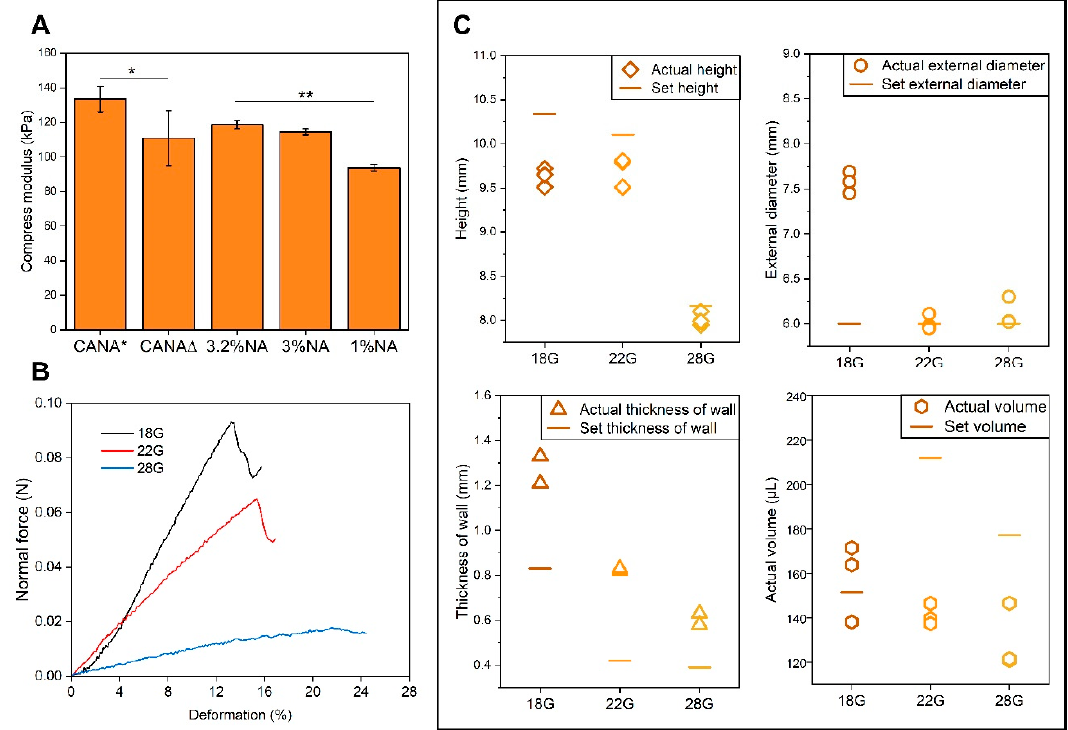
Figure 3. ( A ) Compressive modulus of di ff erent hydrogels at 4 ◦ C and 37 ◦ C (n = 3). (CANA * represents the compressive modulus of bulk CANA hydrogel at 4 ◦ C, and CANA ∆ represents the compressive modulus of bulk CANA hydrogel at 37 ◦ C. All samples were tested at 37 ◦ C after equilibration for 5 min at 4 ◦ C, except that CANA* was tested at 4 ◦ C after equilibration for 5 min at 4 ◦ C. The compression modulus of 1 w / v % NA gels are presented for comparison purposes as it represents the concentration at which NA can be printed through microextrusion printing based on literature (* = p ≤ 0.05, ** = p ≤ 0.01, n = 3). ( B ) Force-displacement curves in response to imposition of normal force (n = 3). ( C ) Comparison between prescribed dimension in the g-code and measured dimension (height, external diameter, thickness of wall, and volume contained within the printed cylinder, n = 3) of hollow cylinders printed using 18G, 22G, and 28G